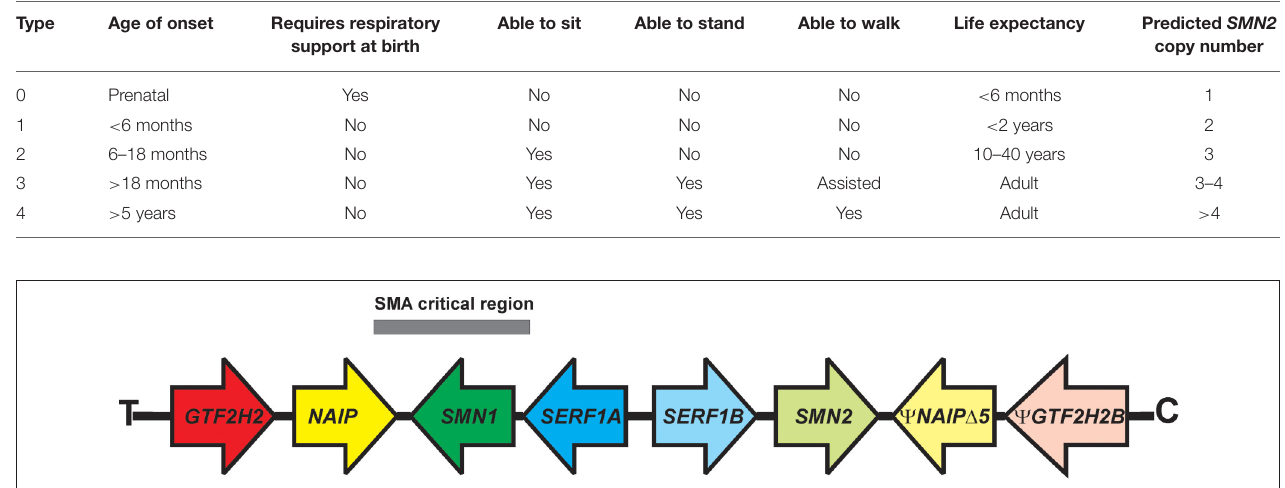
FIGURE 1 | Organization of the inverted duplication locus on 5q13. 4 protein-coding genes— GTF2H2 ( general transcription factor IIH ), NAIP ( neuronal apoptosis inhibitory protein ), SMN1 ( survival motor neuron 1 ), and SERF1A ( small EDRK-rich factor 1A )—are present within the 500-kilobase inverted duplication on the long arm of chromosome 5 (5q13.2). The duplicated genes are Ψ GTF2H2B ( GTF2H2 pseudogene ), Ψ NAIP 1 5 ( NAIP pseudogene with loss of exon 5 ), SMN2 , and SERF1B . The SMA critical region is under the gray bar. C, centromeric end; T, telomeric end.